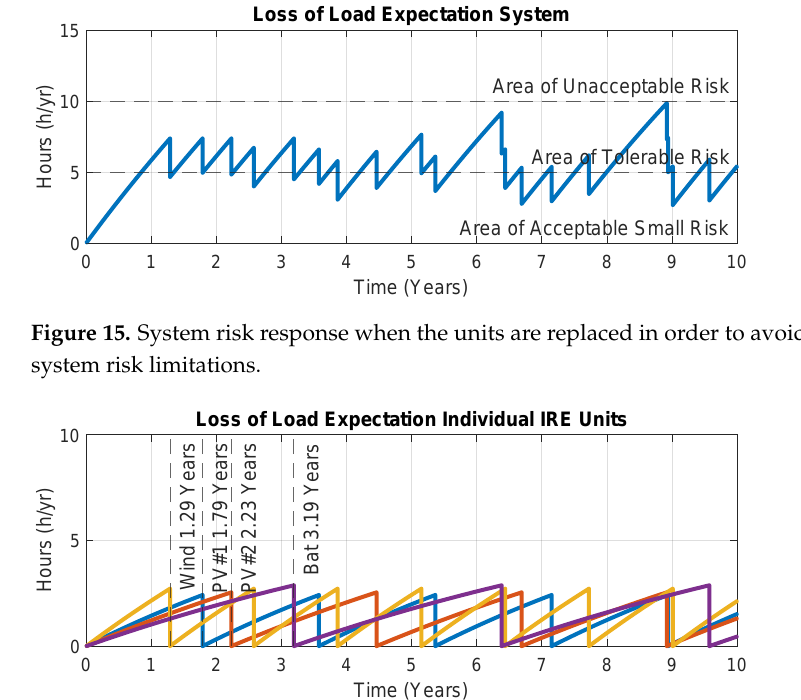
Figure 16. The replacement policy of the power electronic converters needed to prevent a violation of the adopted system risk